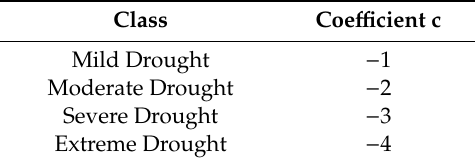
Table 3. The determination of the coe ffi cient c by using the Palmer classification.